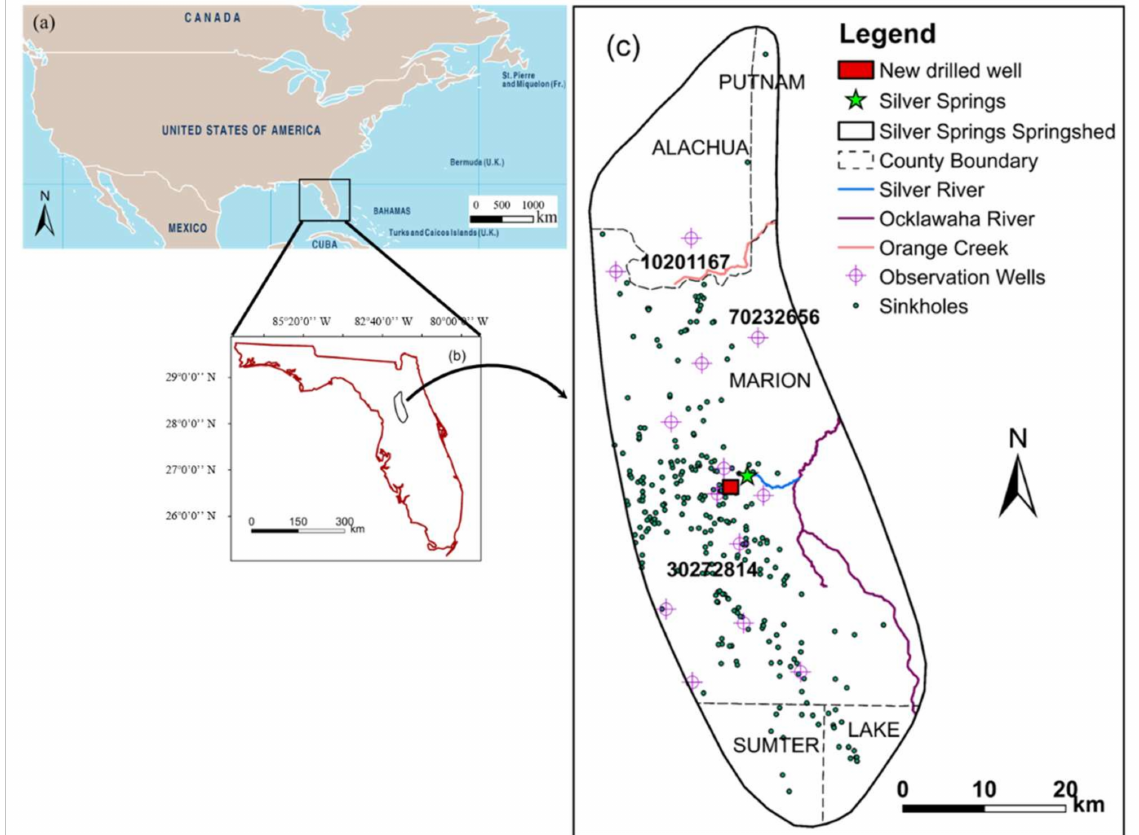
Figure 1. ( a ) The overall view of the U.S. and the location of the Silver springshed; ( b ) location of the Silver springshed in the state of Florida, USA; ( c ) the observation wells, sinkholes, Silver Springs, and Silver River within the springshed; well 10201167 and well 70232656 are located in the upper part of the springshed (slightly karstified areas); the new drilled well and well 30272814 are located in the central part of the springshed (highly karstified